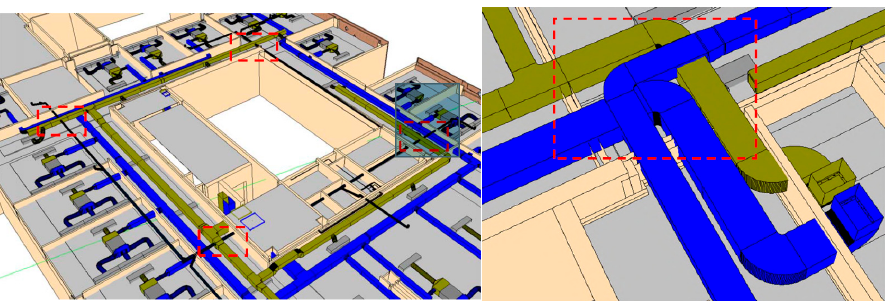
Figure 4. Virtual representation of collision between air conditioning ducts in different scales. BIM Model. The general view ( left ) and the deailed view ( right ).